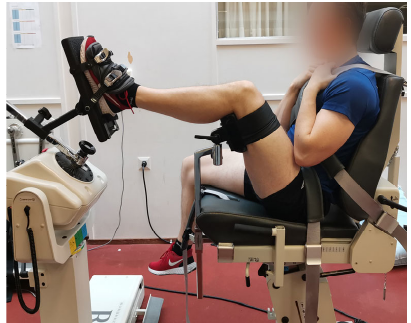
Figure 2. Testing position of ankle inversion/eversion strength measurement.